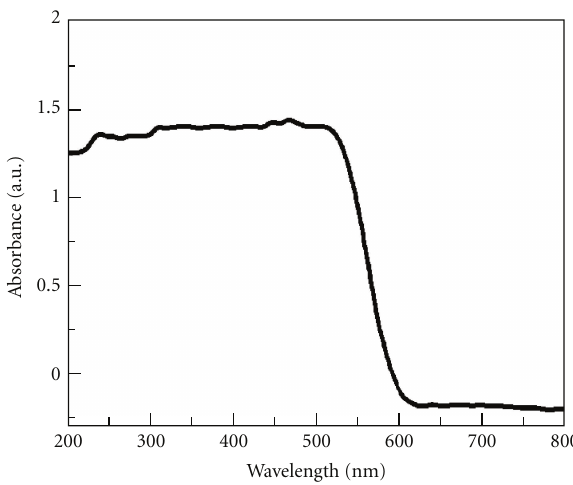
Figure 4: UV-Vis di ff use reflectance spectrum of the mesoporous BiVO 4 nanorods.